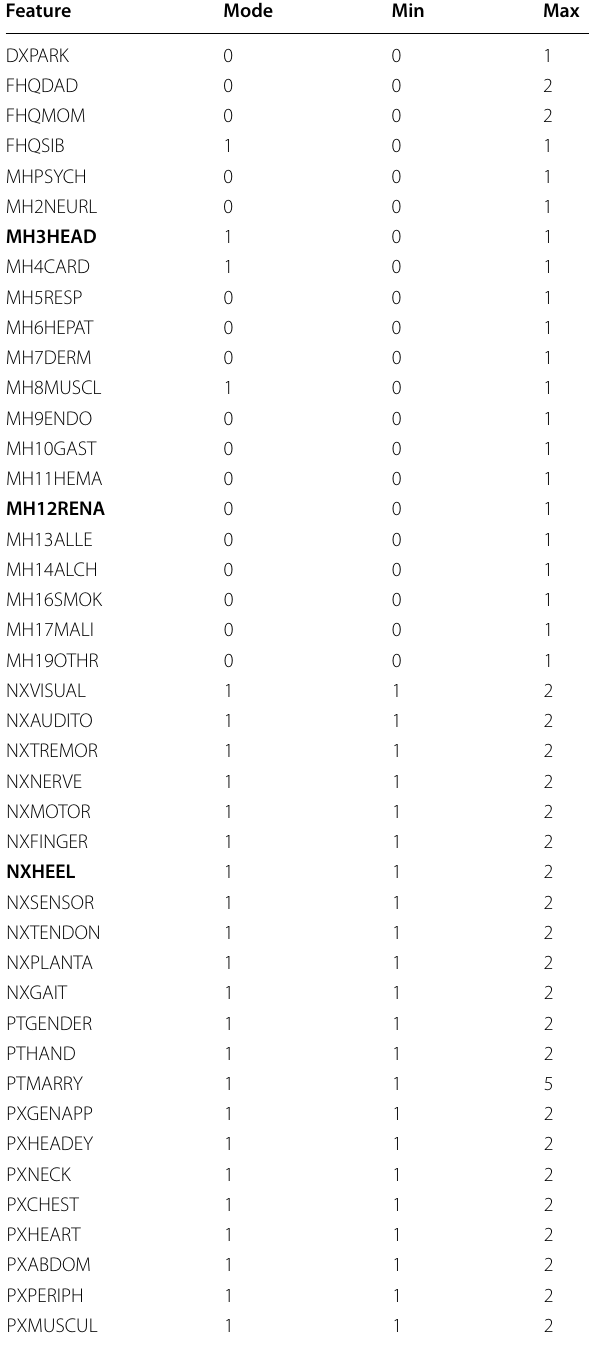
Table 3 Descriptive statistics for the nominal data of all subjects (525)